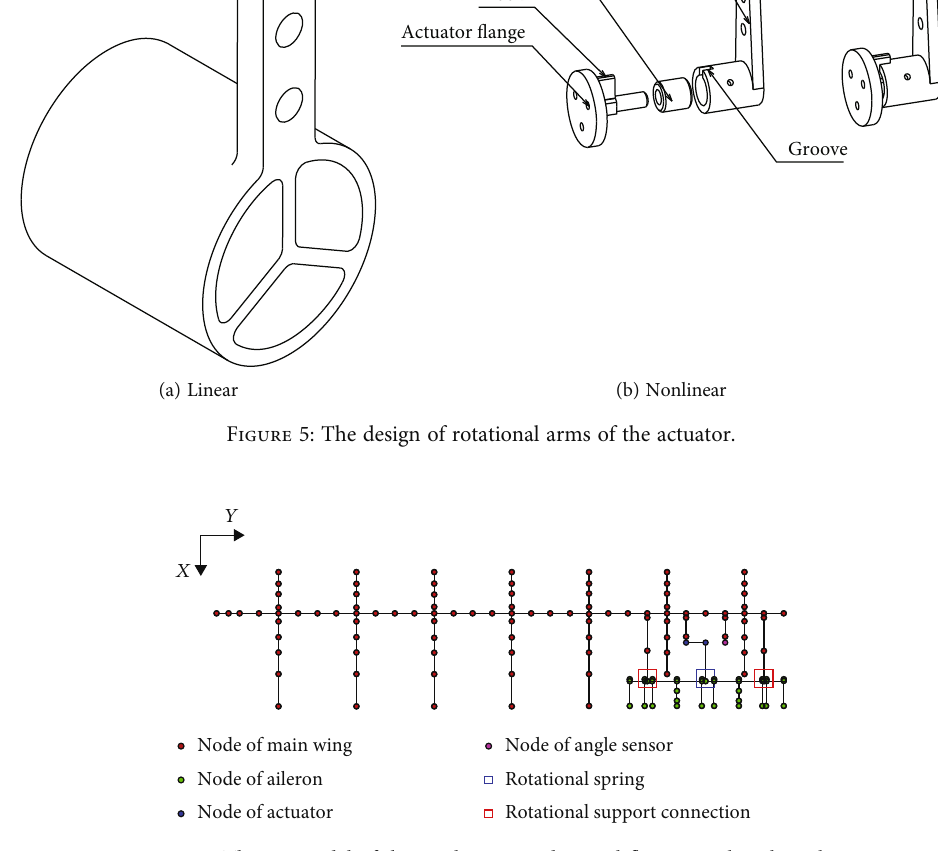
Figure 6: The FE model of the nonlinear wind tunnel fl utter test